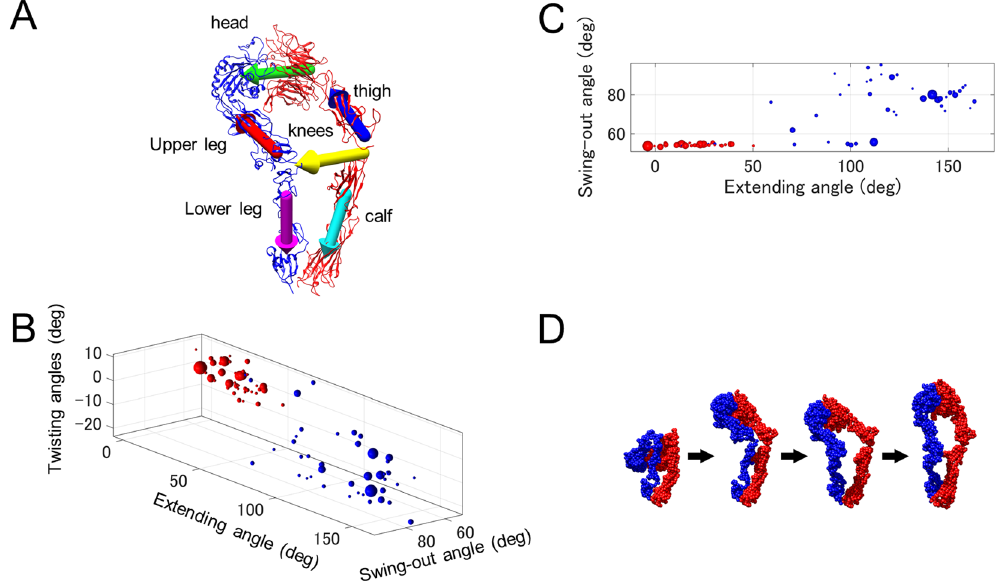
Figure 6. Conformational analysis of integrin based on the 2D hybrid analysis. ( A ) Illustration of axes used for calculating characteristic angles of atomic model of integrin. The first principal axes of inertia of five components (head, thigh, upper leg, calf, and lower leg) are indicated by arrows of different colors (head, green; thigh, blue; upper leg, red; calf, cyan; and lower leg, magenta). In addition, the yellow arrow connects the “knees” of the two chains. ( B ) Scattergram of conformations. A sphere is drawn at the position defined by the three characteristic angles of each conformation. The radius of the sphere is proportional to the number of times the conformation was observed ( c p n r ). Red spheres are for integrins in Ca 2 + solution, and blue spheres are for those in Mn 2 + solutions. ( C ) Projection of scattergram of ( B ) to the plane formed by the extending and swing- out angles. ( D ) Conformational pathway deduced from distribution of conformations. The bent conformation (the left end) is extended halfway (the second). Then, the swing-out deformation occurs (the third). Finally, the conformation is extended fully (the right